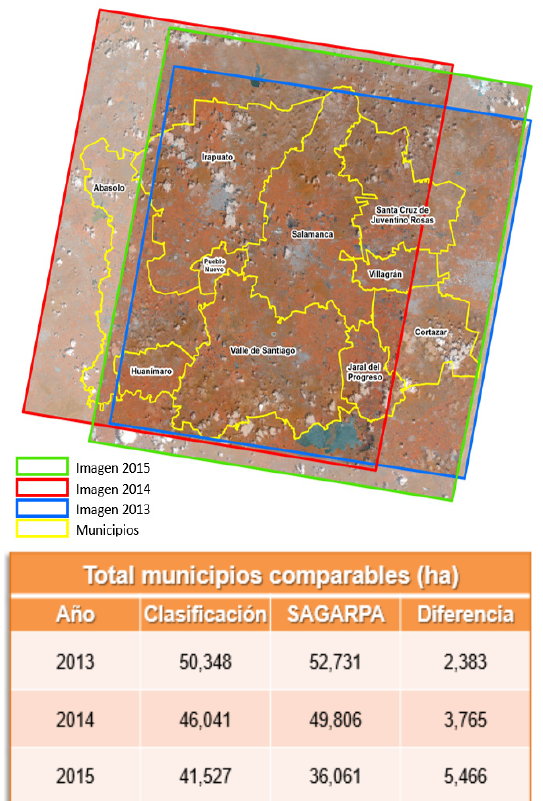
Figure 4. Results obtained by SAGARPA and INEGI The results of the classification throw a downward trend of 4,400 hectares per year between 2013 and 2015, a situation similar to that reflected in SADER